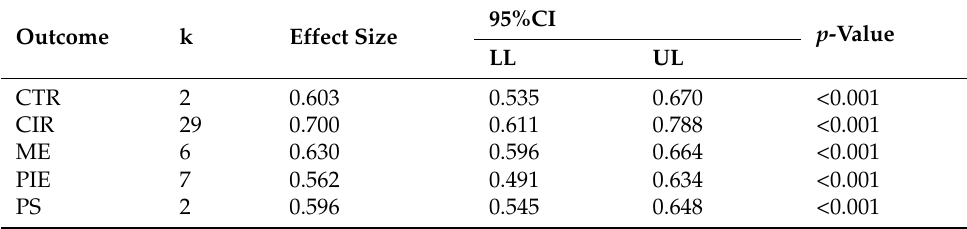
Table 4. EGBD and five dimensions of influencing factors of the meta-analysis results.